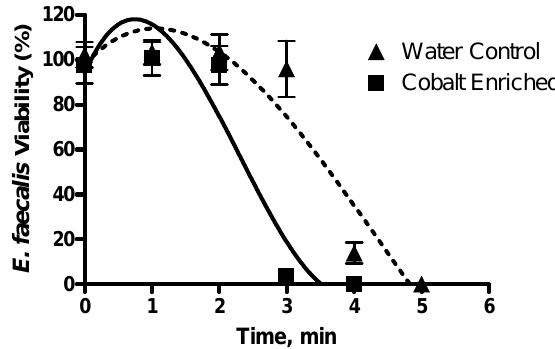
Figure 1: Effect of cobalt ions on microwave disinfection of E. faecalis. Shows the effect that cobalt ions (solid line) have on the deactivation of E. faecalis (n = 10) during microwave heating compared to a distilled water control (dotted line). Cobalt ions reduced the time necessary for microwave disinfection of E.